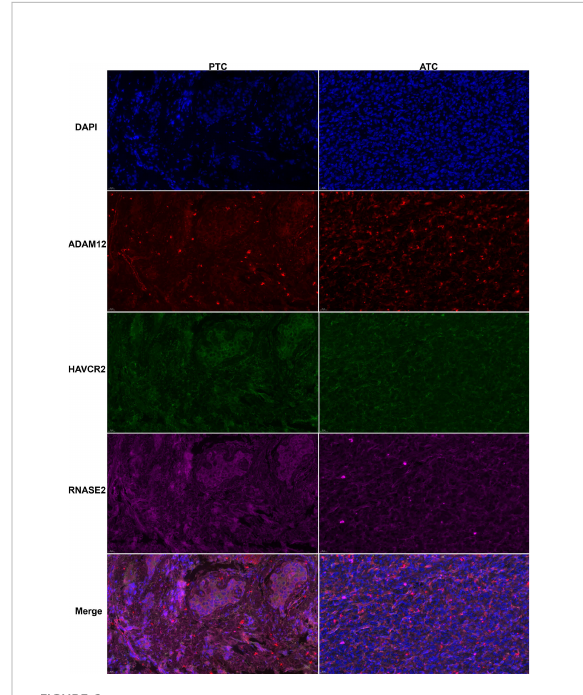
FIGURE 6 Typical triple immuno fl uorescence staining for ADAM12 (red), HAVCR2(green), and RNASE2 (purple) localization in PTC and ATC samples ( X